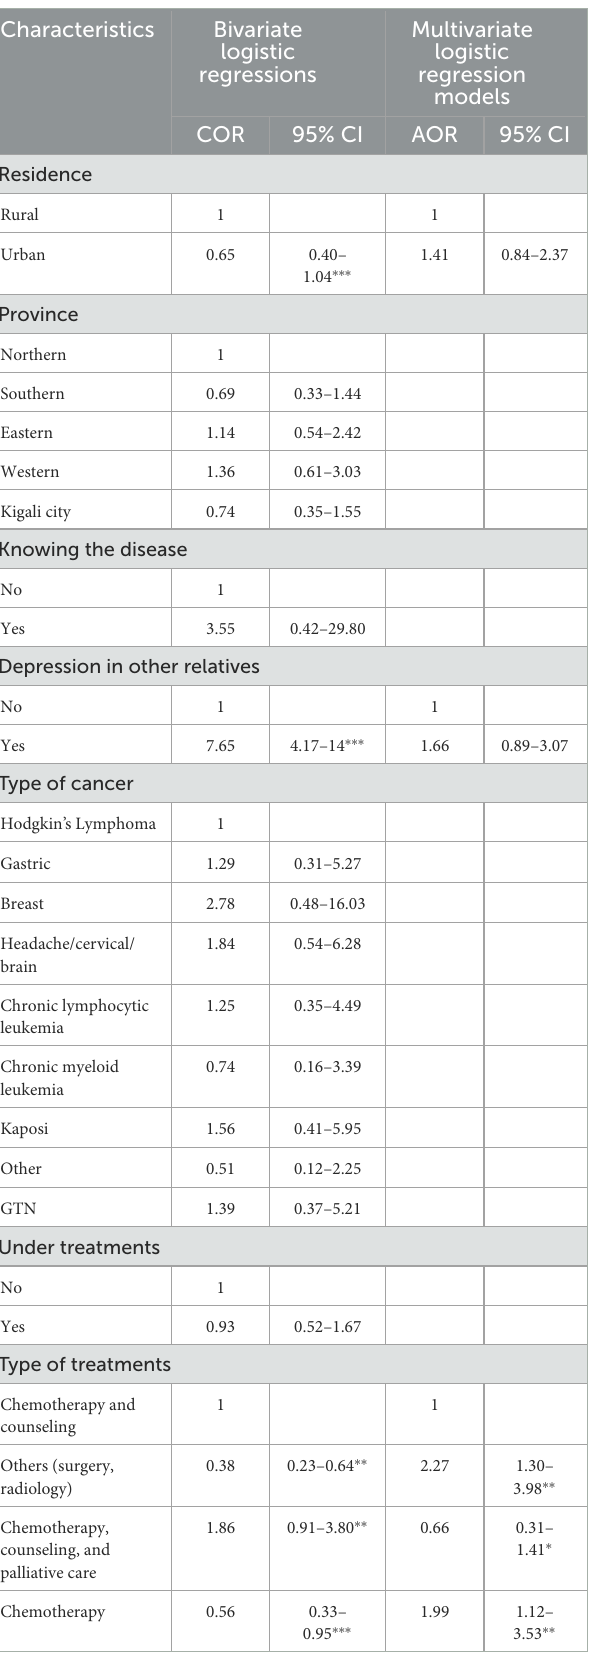
TABLE 4 Bivariate and multivariate logistic regression models for the factors of